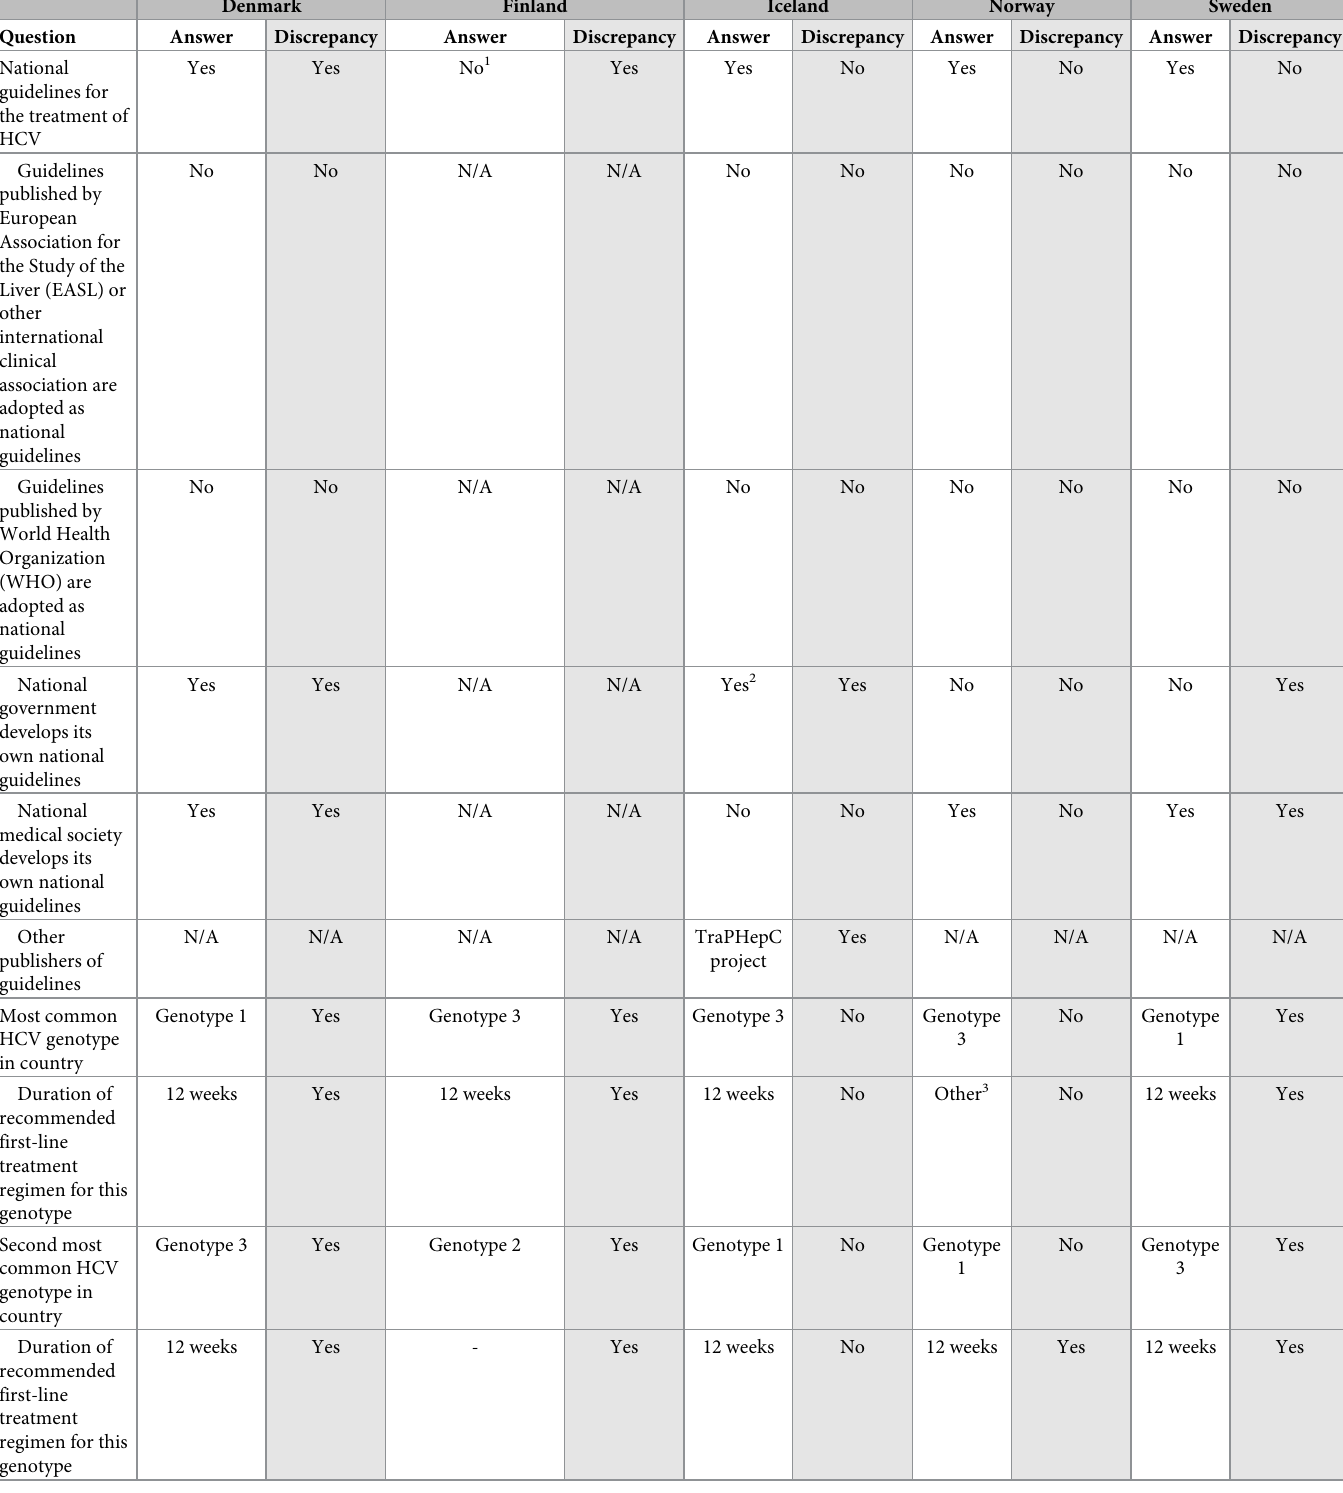
Table 4. HEPATITIS C